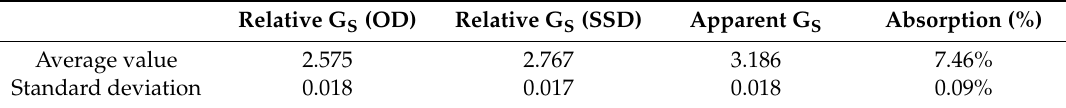
Table 3. Average G S and absorption values for the LMF slag fines.